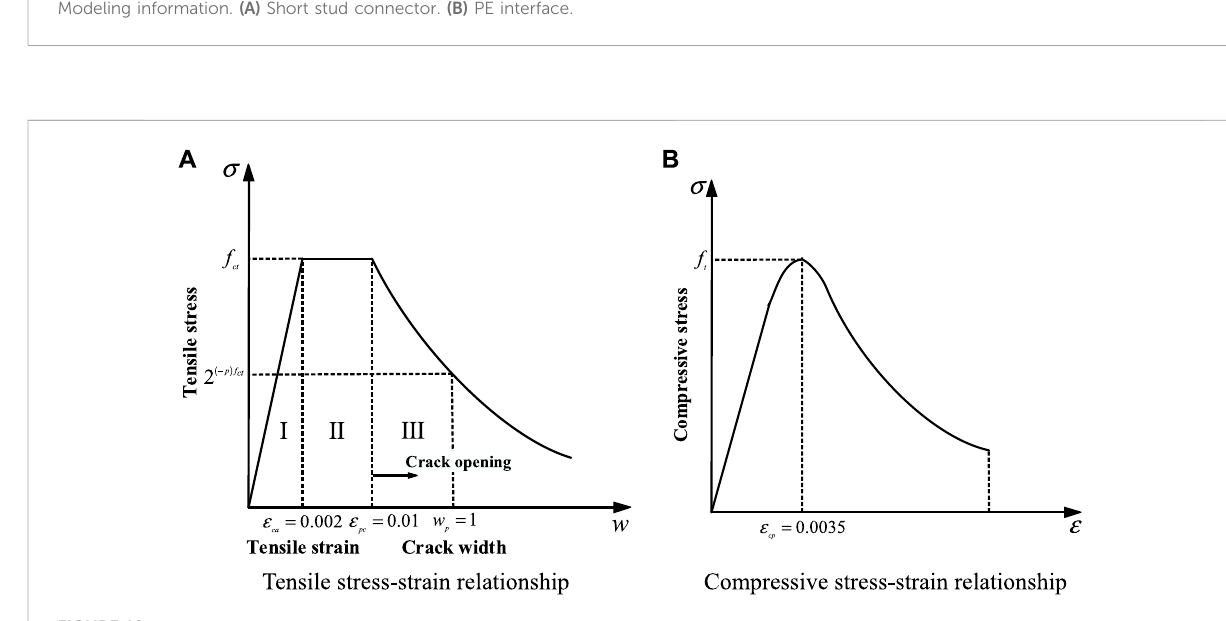
FIGURE 12 Stress-strain relationship of UHPC. (A) Tcnsile stress-strain relationship. (B) Compresssive stress-strain relationship.